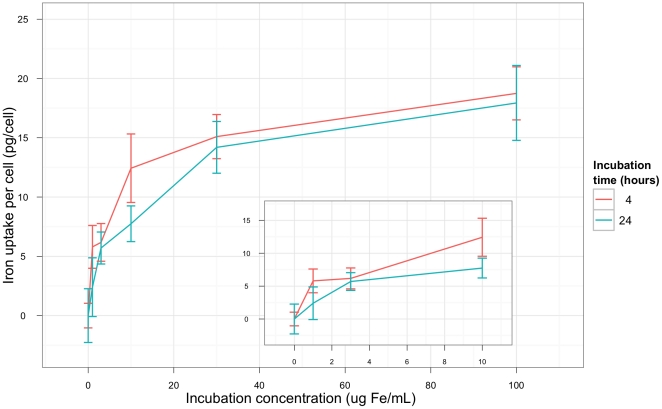
Iron concentrations in macrophages treated with SPIO particles.The amount of SPIO particle uptake by macrophages was measured using a spectrophotometer. Data are presented as mean ± SEM, n = 3. The basal iron content (of the control macrophages) was subtracted from the values. The incubation concentration of SPIO has a strong influence on the amount of particle uptake. There was some (but not significant) increase in intracellular SPIO particle uptake following a long incubation period (24 h) compared to a shorter one (6 h). The maximum particle uptake was observed at 100 µg Fe/ml SPIO, which was statistically significant when compared to the control.